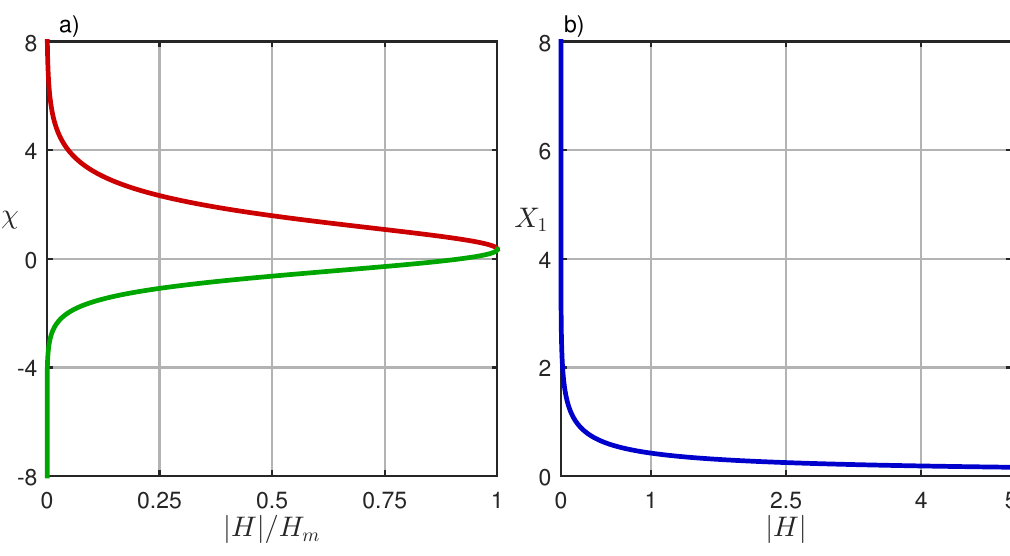
Figure 4 . a) The two real solutions of eq. (4.7) for χ ( H ): X 0 (red) and ˆ X 0 (green); b) the unique real solution X 1 ( H ) of eq. (